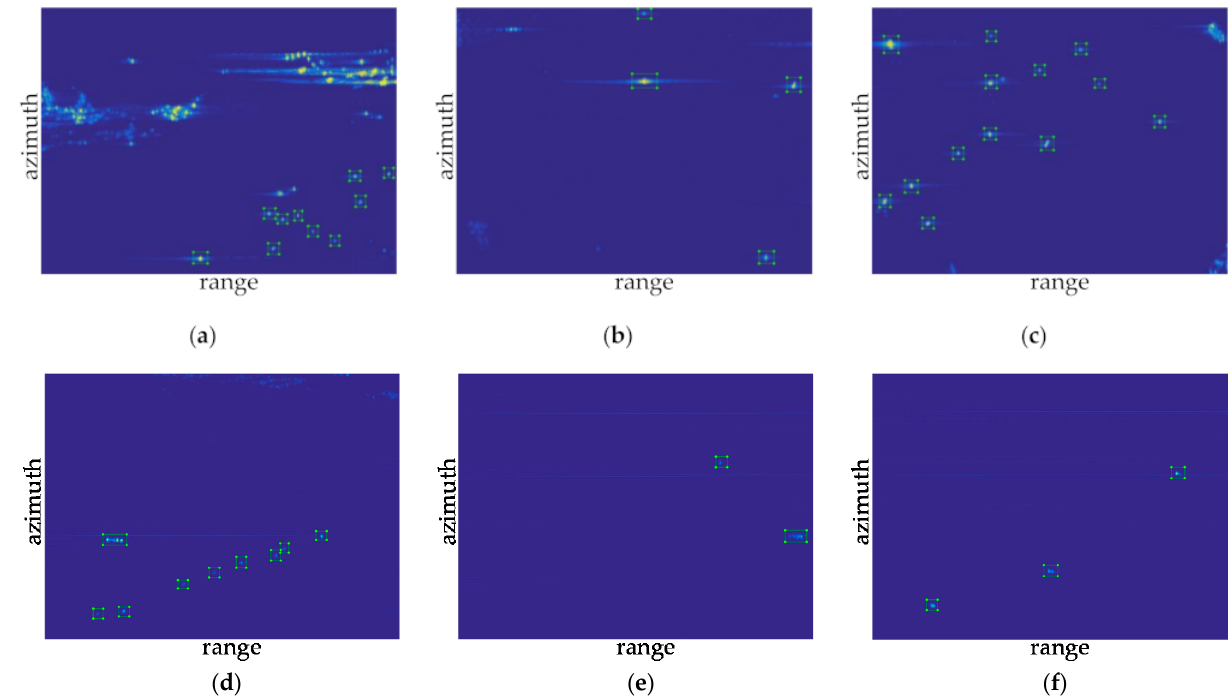
Figure 15. The annotated image samples: ( a ) sample 1; ( b ) sample 2; ( c ) sample 3; ( d ) sample 4; ( e ) sample 5; and ( f ) sample